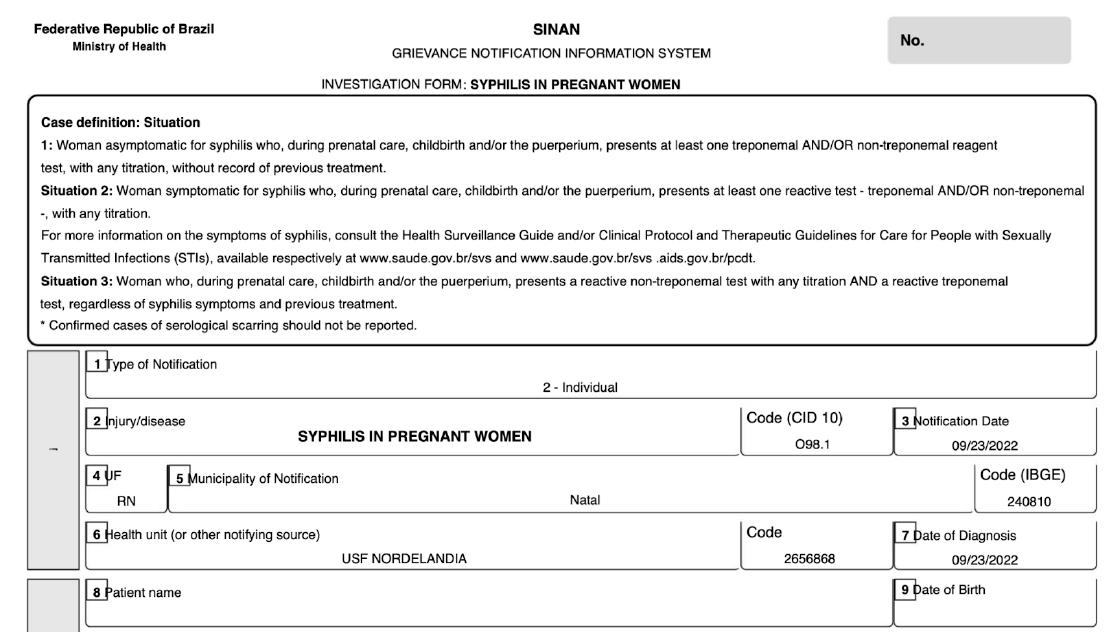
Figure A9. SINAN noti fi cation form.